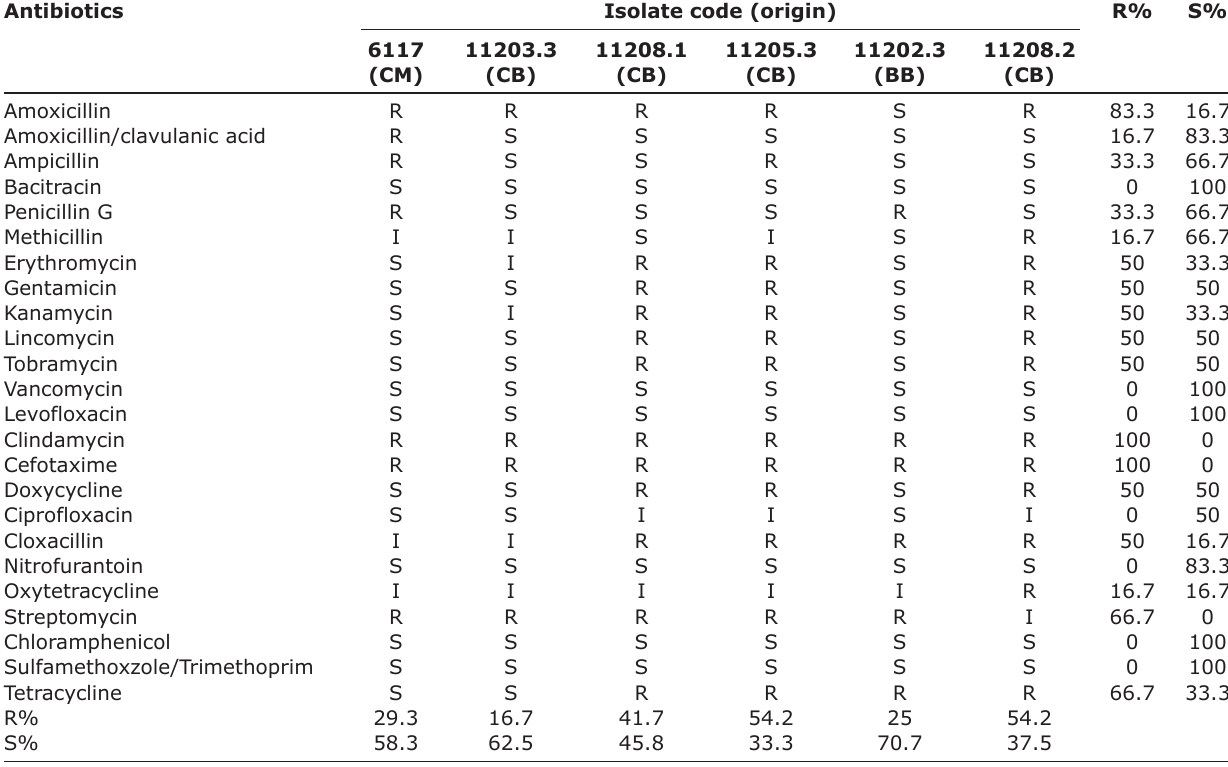
Table-4: Antibiogram results of selected S. aureus isolated from meat and meat products samples.